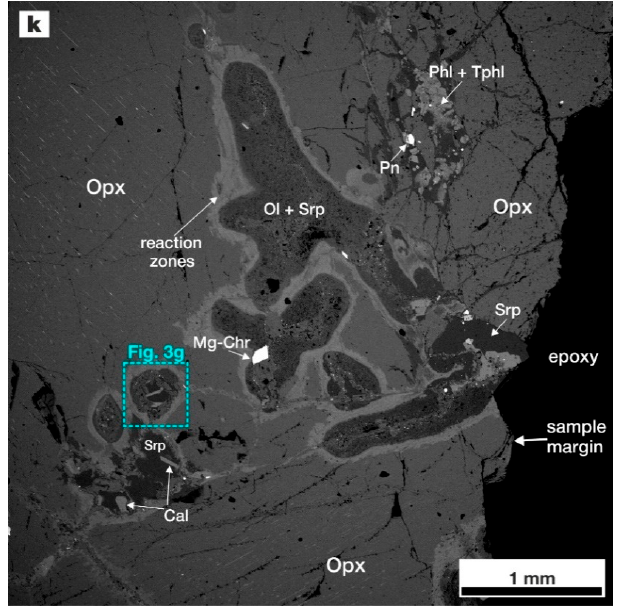
Figure 3. ( a ) Polished thin section made up of the orthopyroxenite with a marginal part containing Figure 3. Cont . crystallized melt inclusions; ( b–j ) BSE images depicting close-ups of the crystallized melt inclusions; (k) BSE image depicting a general view of the crystallized melt inclusions in orthopyroxene. Mineral abbreviations are those described in the Section “Materials and Methods” and Table 1.